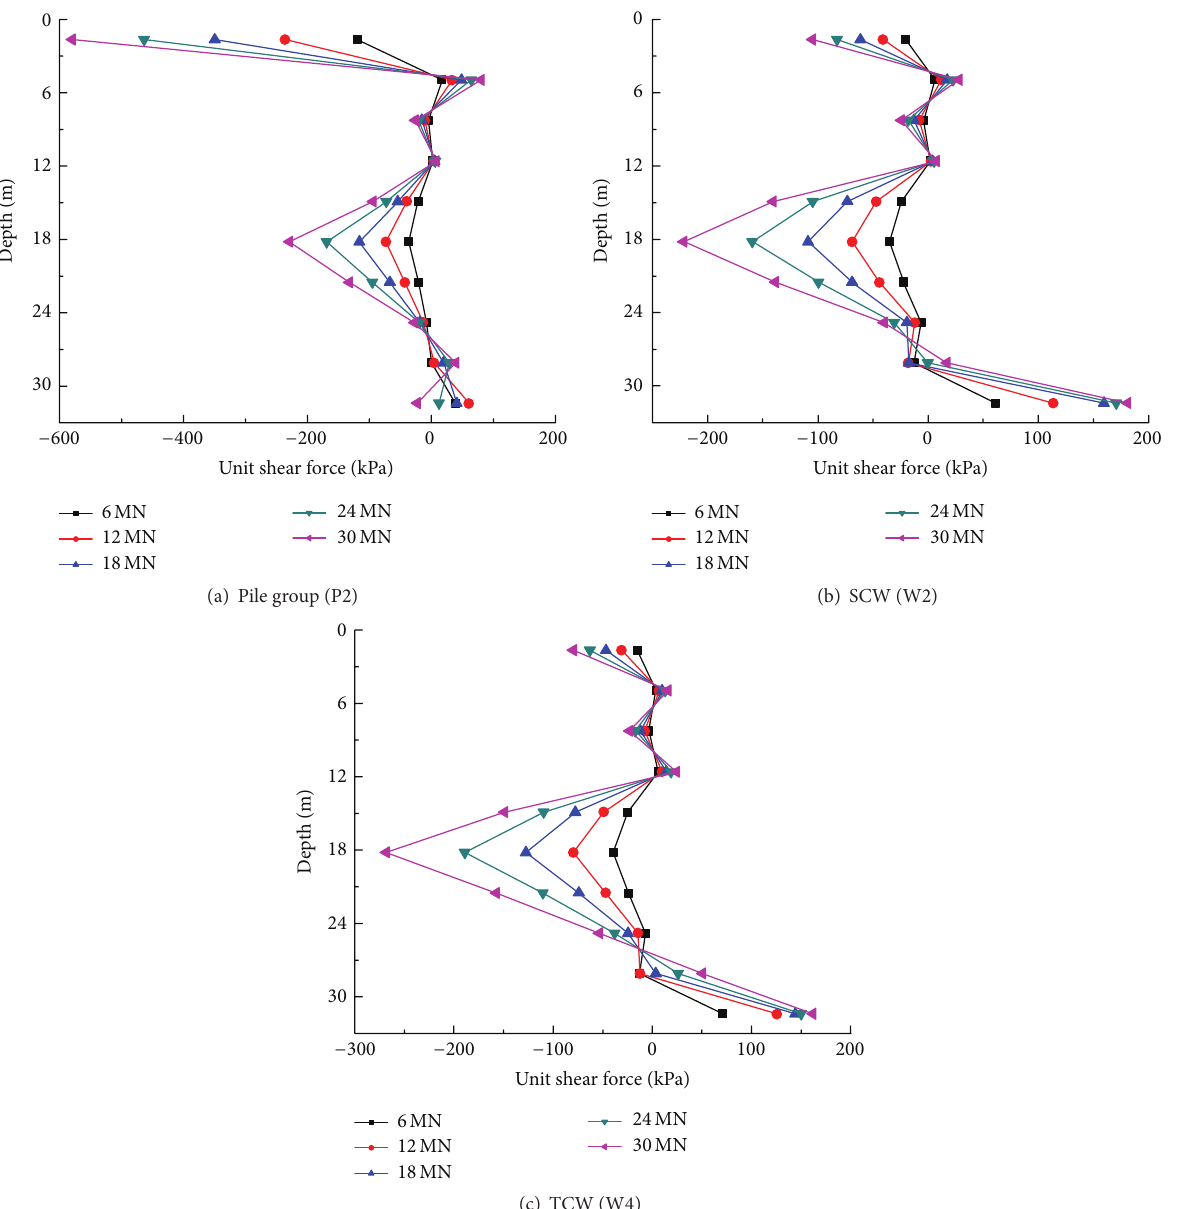
Figure 8: Unit shear forces of three models under different